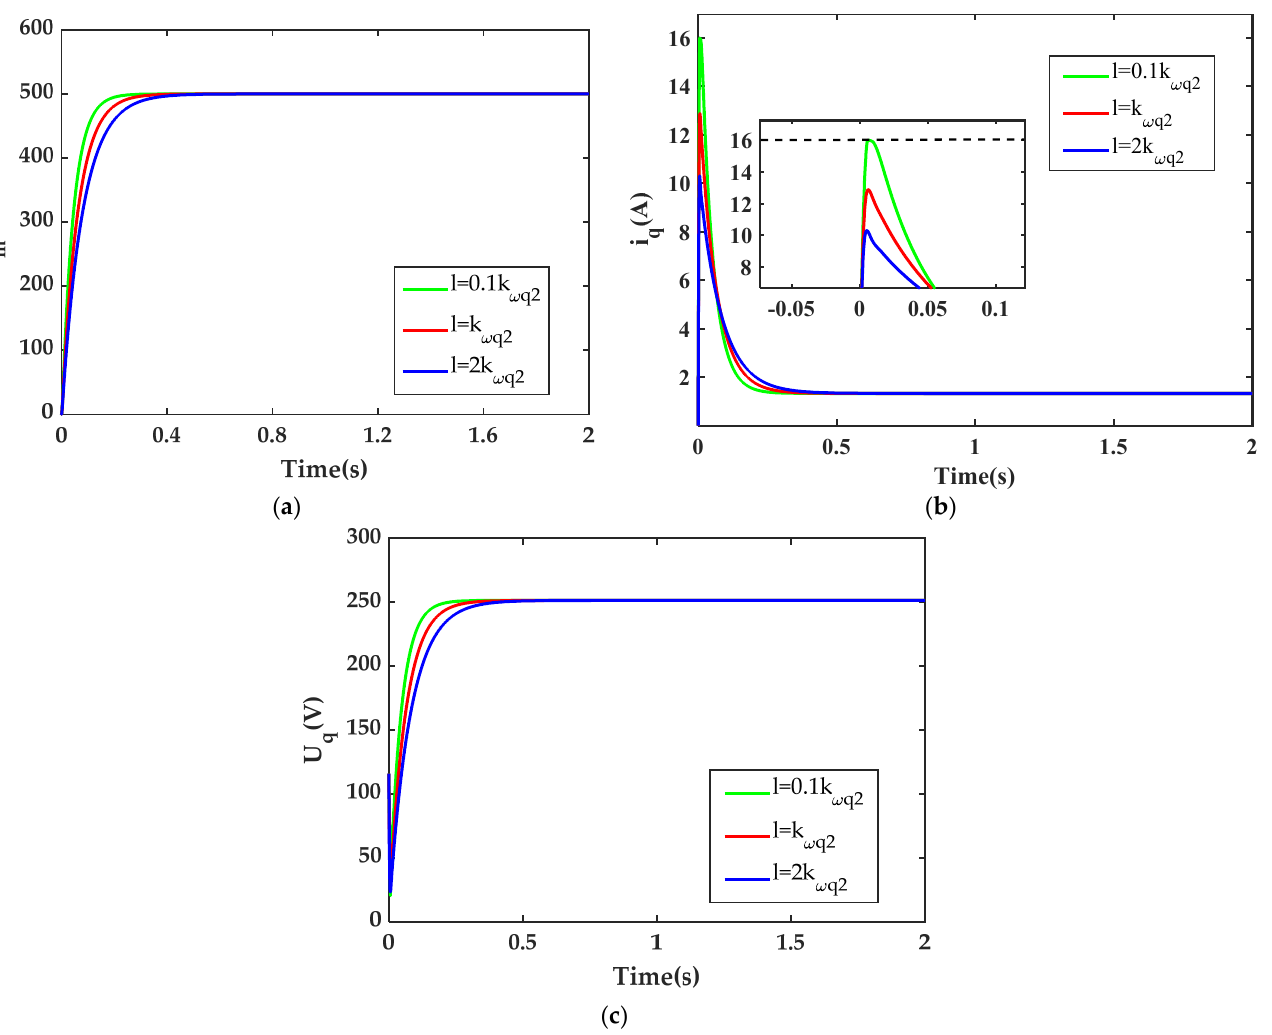
Figure 4. Performance comparisons under CACADRC with different current penalty coefficients l .